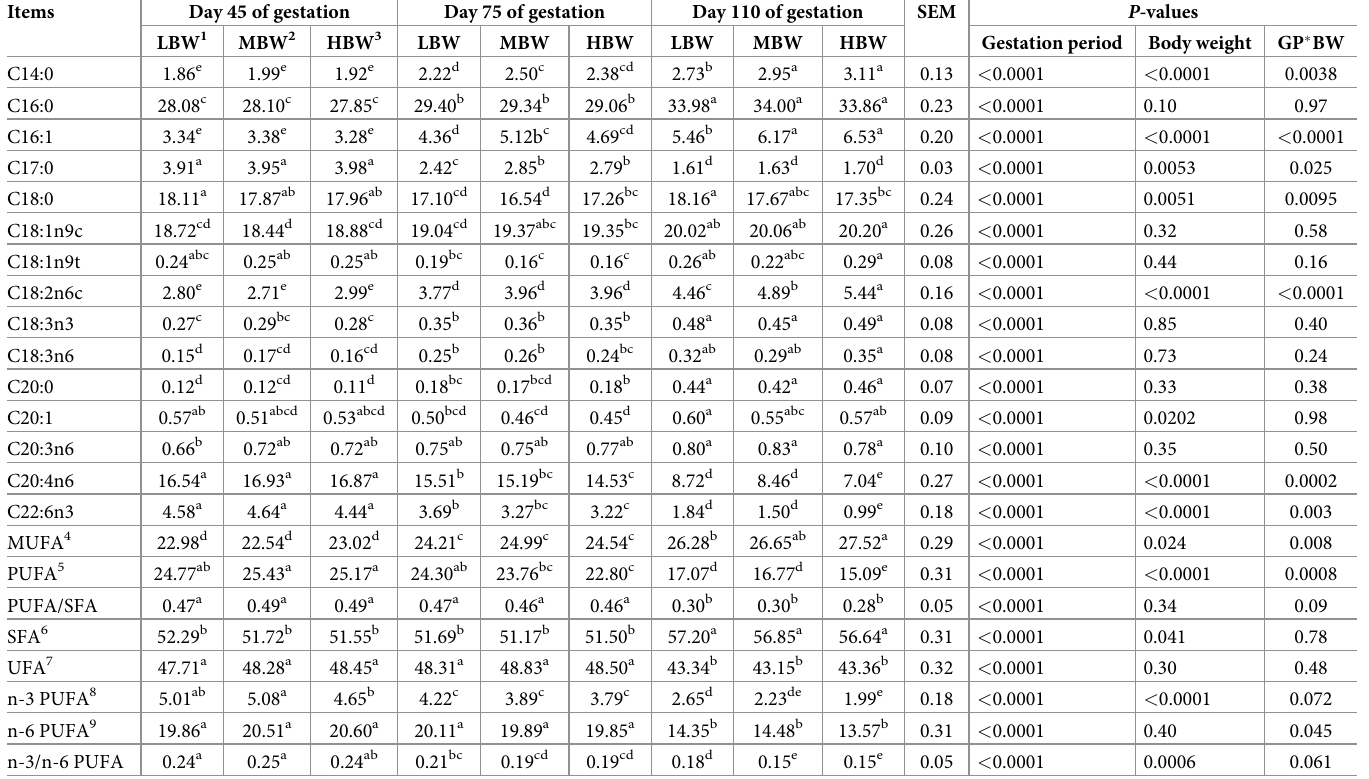
Table 6. Composition of fatty acid of fetal pigs with LBW, MBW, and HBW at different gestation period (%; n =